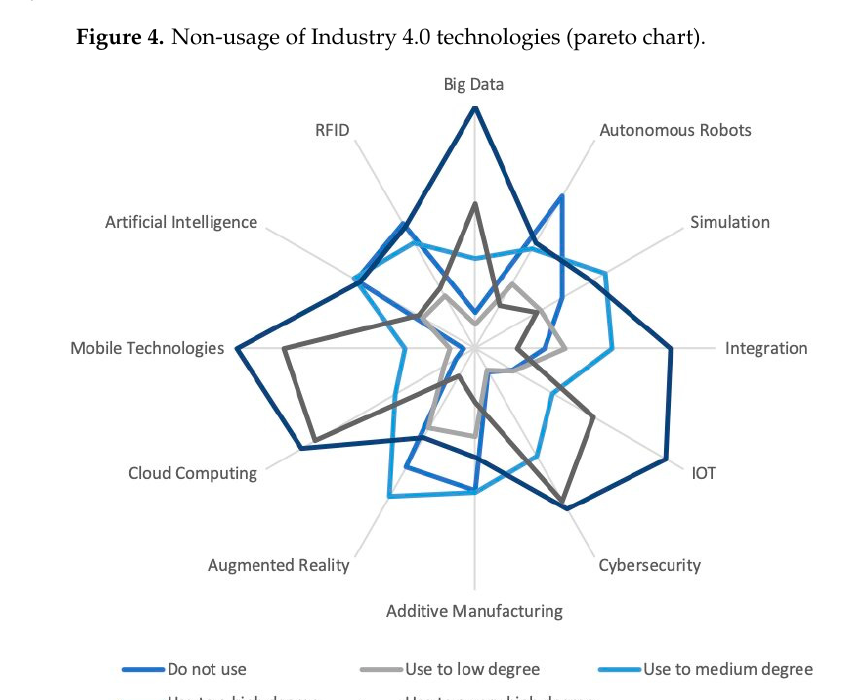
Figure 5. Industry 4.0 technologies (radar chart in terms of technologies).